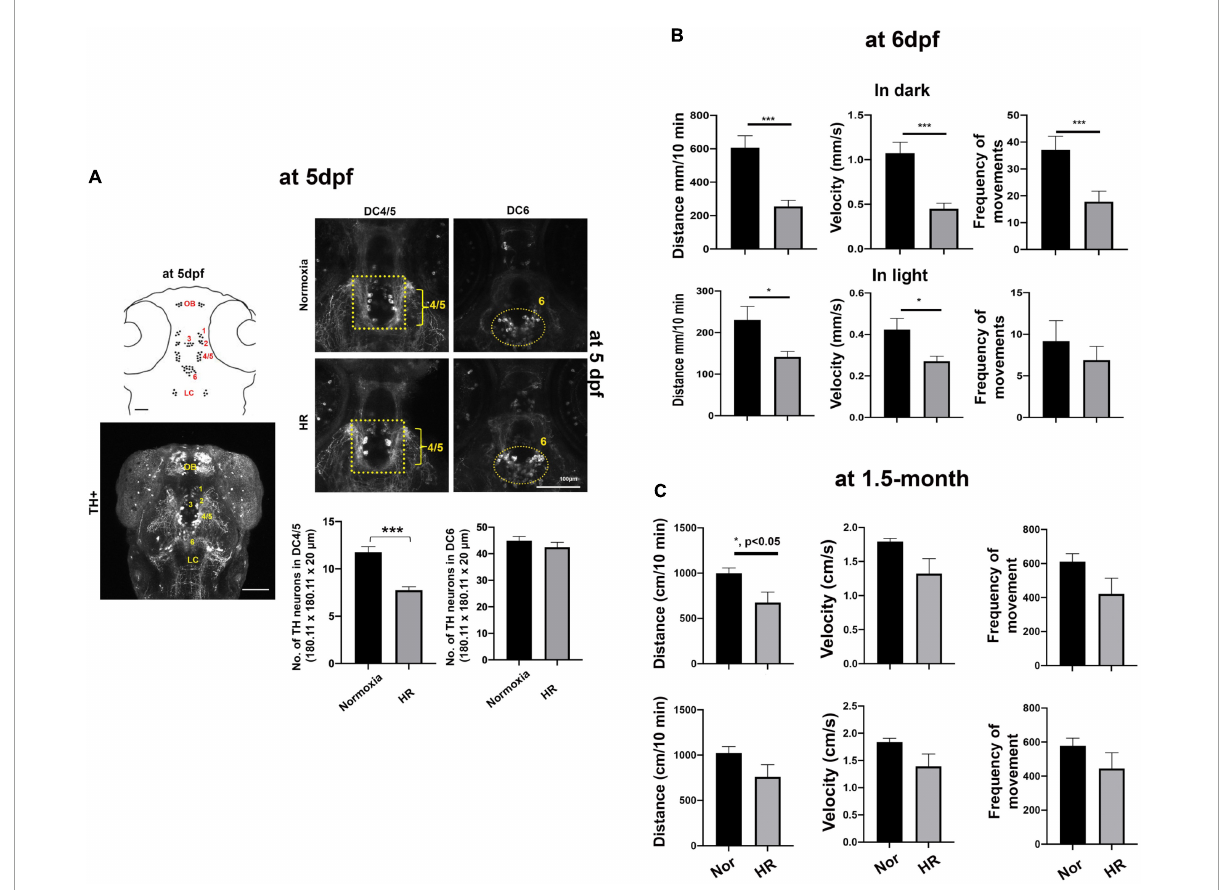
FIGURE3 (A) A schematic drawing (left, top panel) and Z-stack confocal image (left, bottom panel) of diencephalic TH + DA neurons at 5 dpf, including in DC1, DC2, DC3, DC4/5, and DC6. (A) Z-stack confocal images of the anti-TH immunohistochemistry were analyzed in the DC4/5 and DC 6 areas (180.11 µ m × 180.11 µ m × 20 µ m) in HR zebrafish ( n = 23) compared to normoxic controls ( n = 20) analyzed with Student’s t -test and presented as Means ± SEM. *** p < 0.001. (B) Developmental hypoxia results in disrupted swimming maturation at 6 dpf. Data plots (Means ± SEM) show the averaged swimming distance, velocity, and frequency of movements n the dark (3 × 10 min) and in light (3 × 10 min) in HR larvae ( n = 24) compared to normoxic controls ( n = 24). Student’s t -test, *** p < 0.001, and * p < 0.05. (C) Developmental hypoxia causes reduced swimming distance in dark in 1.5-month-old young zebrafish (hypoxia, n = 6 vs. normoxia, n = 6). *** p < 0.001, * p < 0.05.